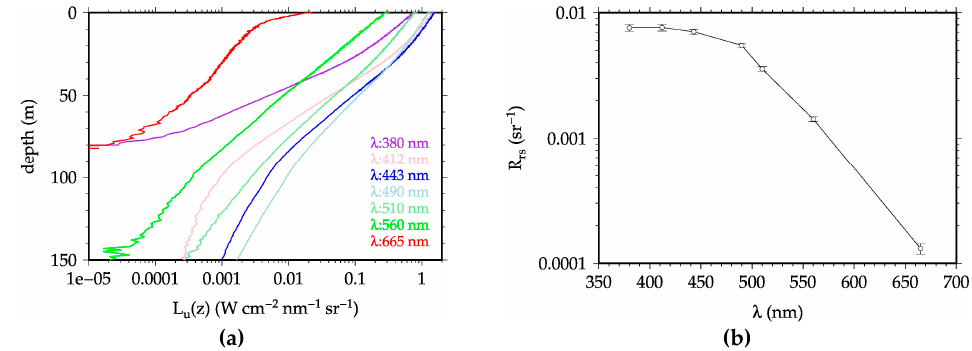
Figure 13. (a) A typical vertical profile of the spectral upwelling nadir radiance at MSEA (ProVal data, 27/09/2019), (b) Average remote sensing reflectance spectrum at MSEA derived from 35 spectra derived from ProVal data collected in 2019 (note the very small standard